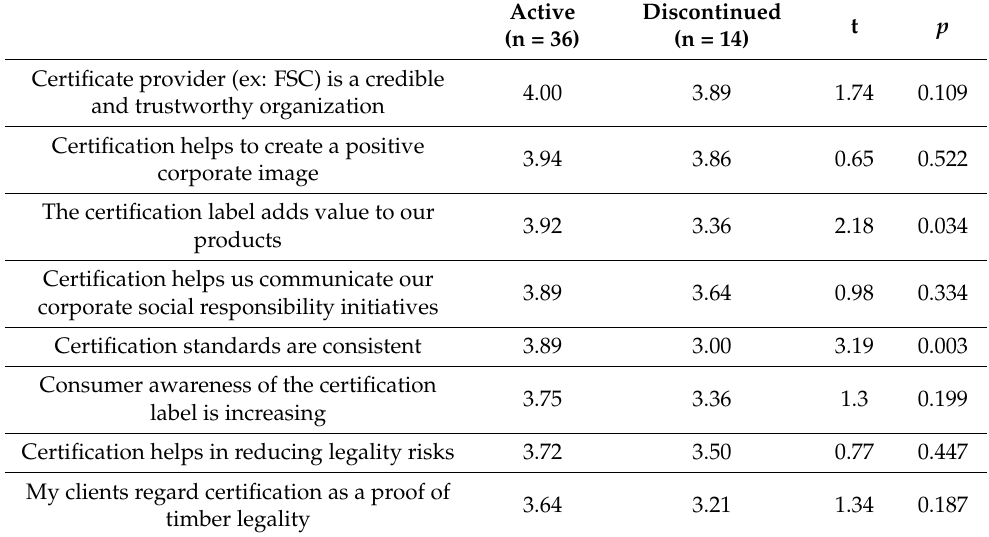
Table 4. Perceptions of respondents that are either currently FSC certified or have discontinued